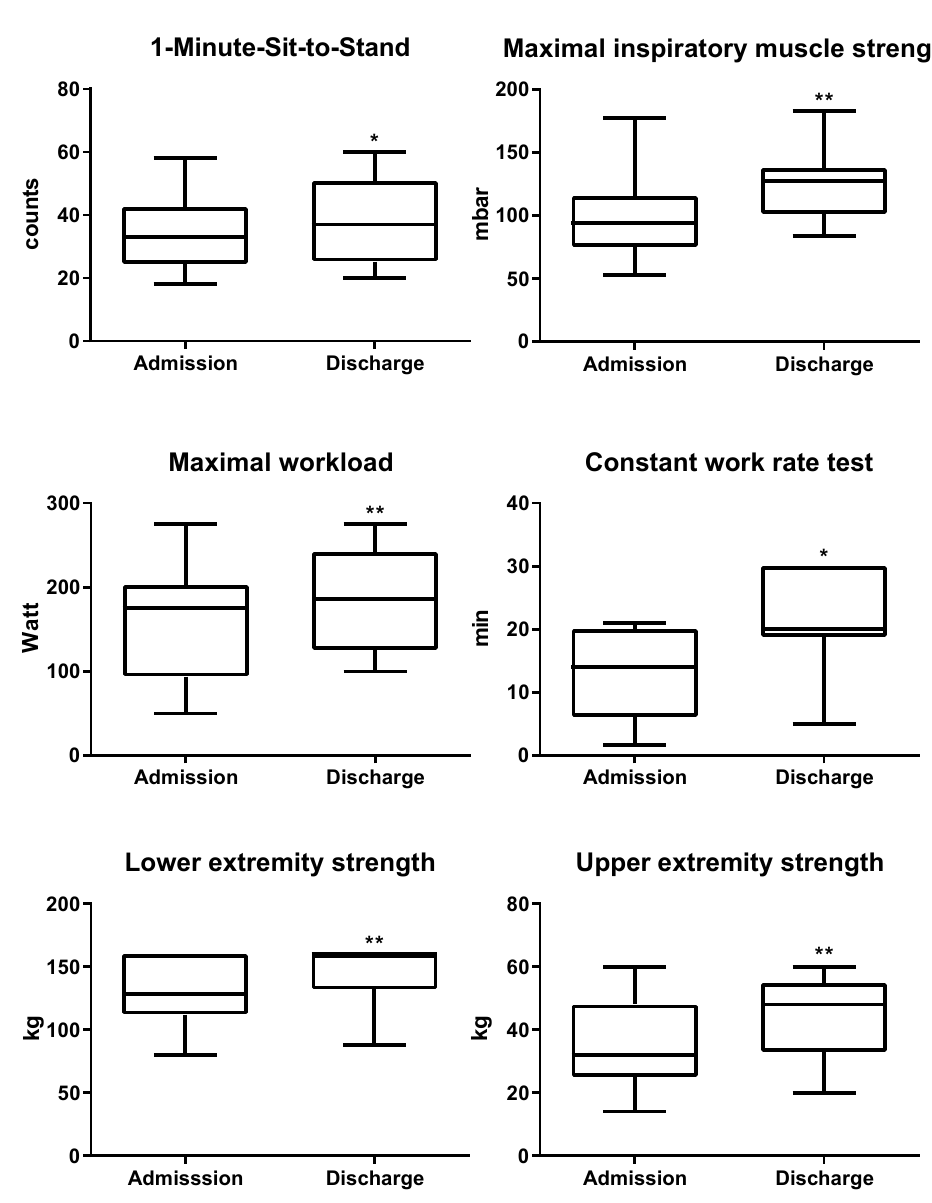
Figure 2. Improvements in secondary outcome parameters after completion of pulmonary rehabilitation. Patients improved significantly in 1-MSTS, maximal inspiratory muscle strength, maximal workload, constant work rate, lower and upper extremity strength; * = p < 0.05; ** = p < 0.001, paired samples t ‐ test.